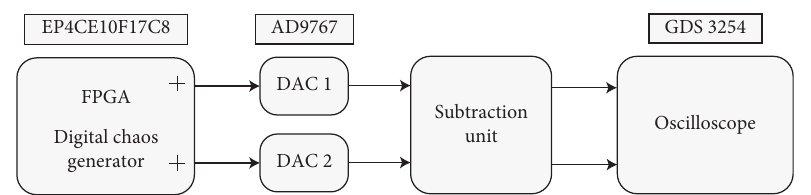
Figure 13: The architecture of experimental hardware platform for the proposed chaotic